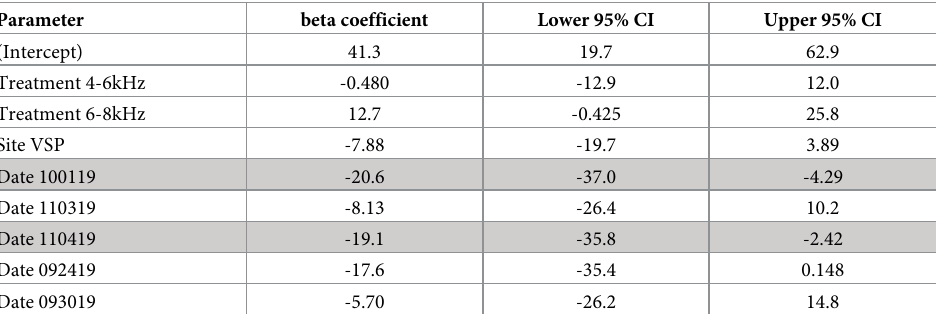
Table 7. Within-flight change in angle of displacement model-averaged parameter